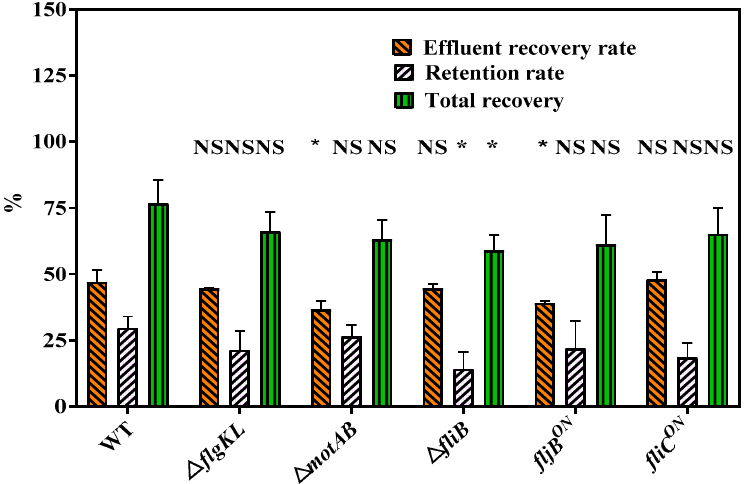
Figure 3. The recovery rate of S. Typhimurium different strains. Replicates are shown as mean values, error bars represent standard deviations, and statistical significances were determined by the student’s t ‐ test (* = p < 0.05; NS = not significant).